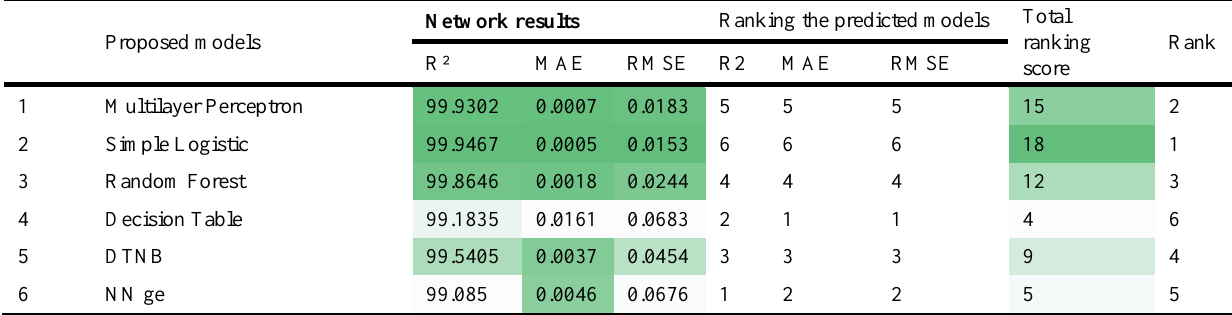
Table 3. Rank of Image classification algorithms evaluation based on the test dataset.